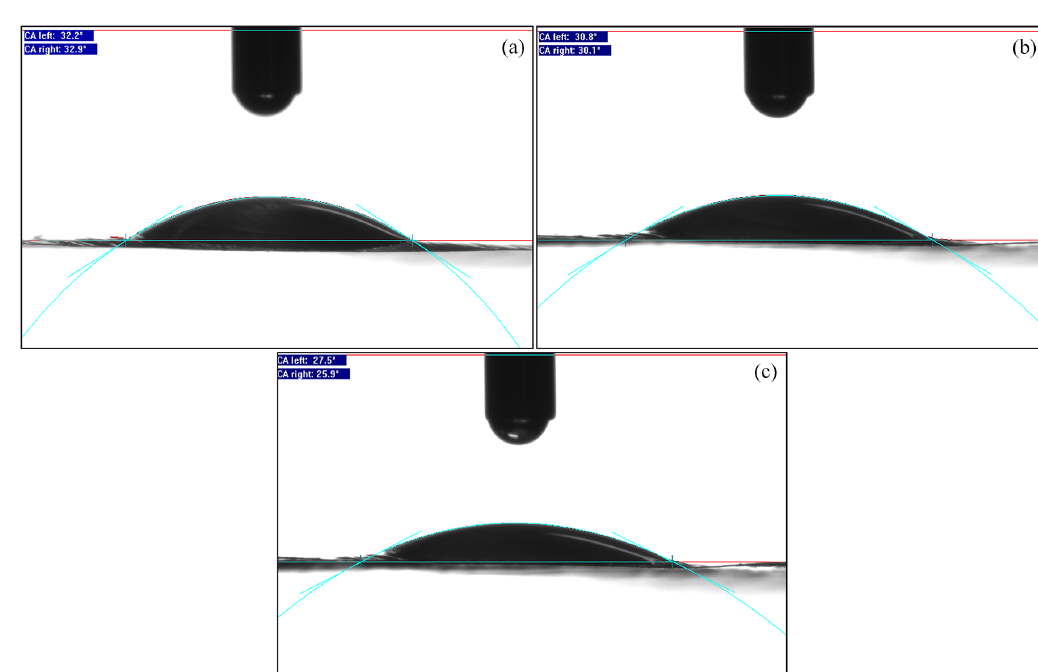
Figure 2. Analysis of contact angle for BC: (a) zero time; (b) 5 seconds; (c) 30 seconds.